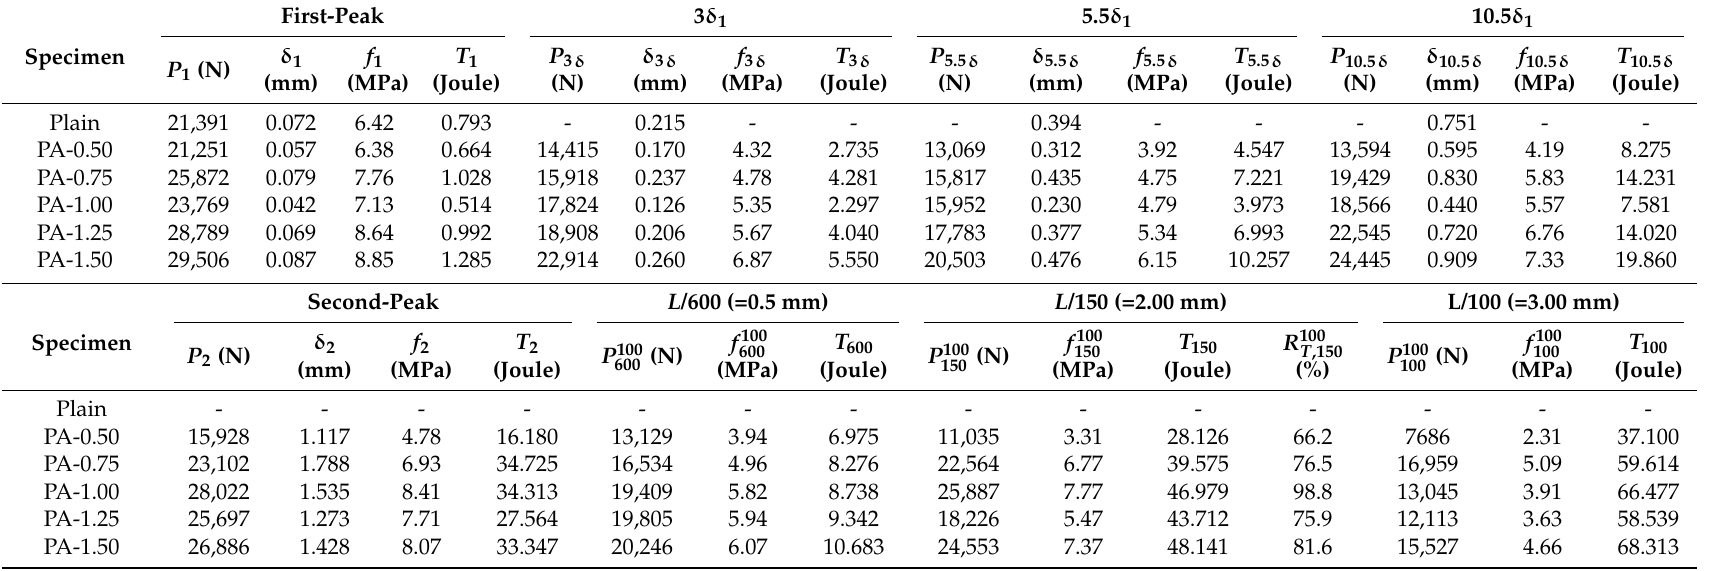
Table 3. Average value of flexural responses of